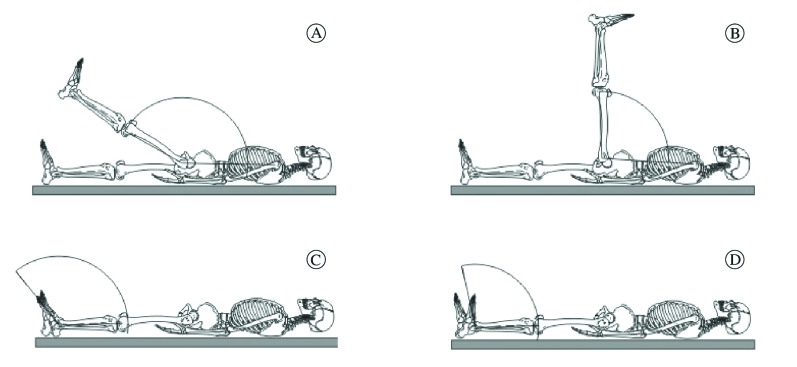
Schematic representation of the hip and ankle joints during the joint
positioning test. Narrow and wide range flexion positions during the joint
positioning sense test of the hip (top panel A and B) and ankle (lower panel
C and D).